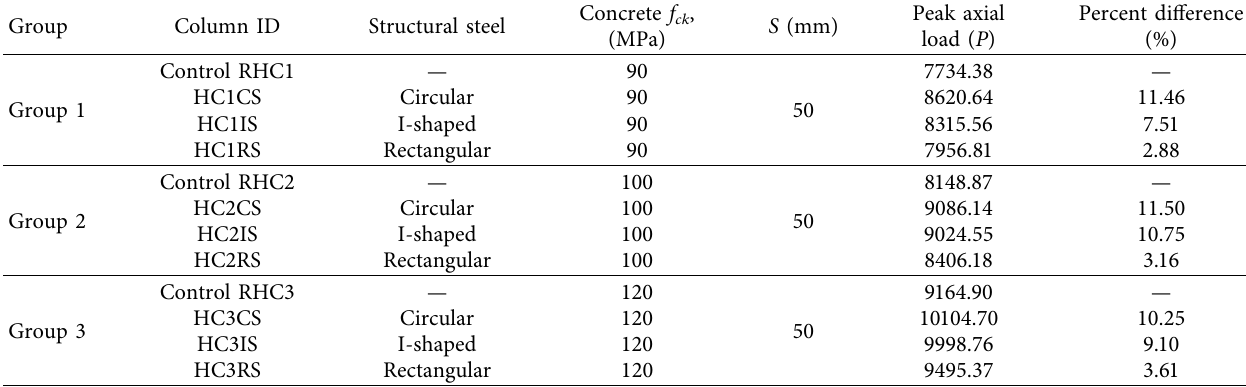
Table 11: Efect of structural steel shape on the axial load capacity of FEC column with s � 50mm.